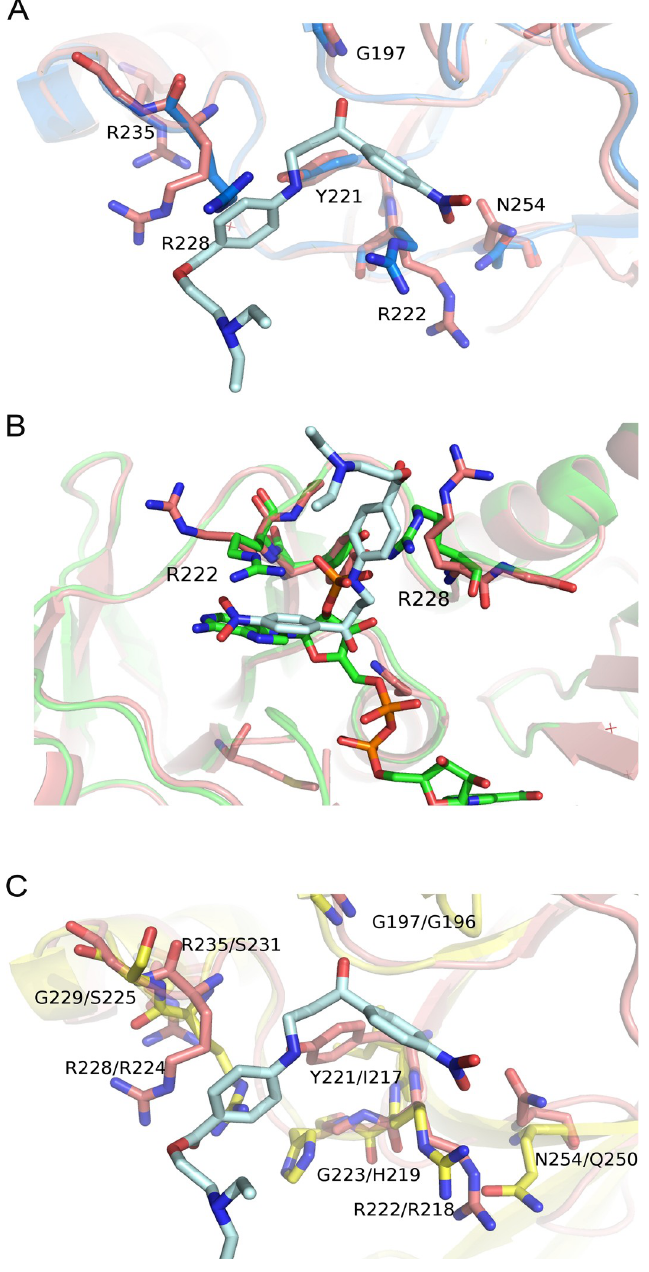
Fig 9. (A) Superimposition between compound 3 -TR complex and the apo TR (PDB code: 2JK6) structures. The structure of apo TR is colored blue, the compound 3 -TR complex is colored magenta. The residues involved in the ligand binding are indicated and represented as sticks. ( B ) Superimposition between compound 3 -TR complex (in magenta) and the reduced TR in complex with NADPH (in green) (PDB code: 2W0H). The two Arginine residues (Arg222 and Arg228) involved in the ligand binding are indicated and depicted as sticks. Compound 3 and NADPH are depicted as sticks and colored in light blue and green respectively ( C ) Superimposition between compound 3 -TR complex (in magenta) and Glutathione reductase (in yellow) (PDB code: 3GRS). The residues involved in the ligand binding are indicated (the residues of the compound 3 -TR complex on the left side and the residues of GR on the right side) and depicted as sticks. The picture was obtained using PyMOL (The PyMOL Molecular Graphics System, Version 2.0 Schro¨dinger, LLC).